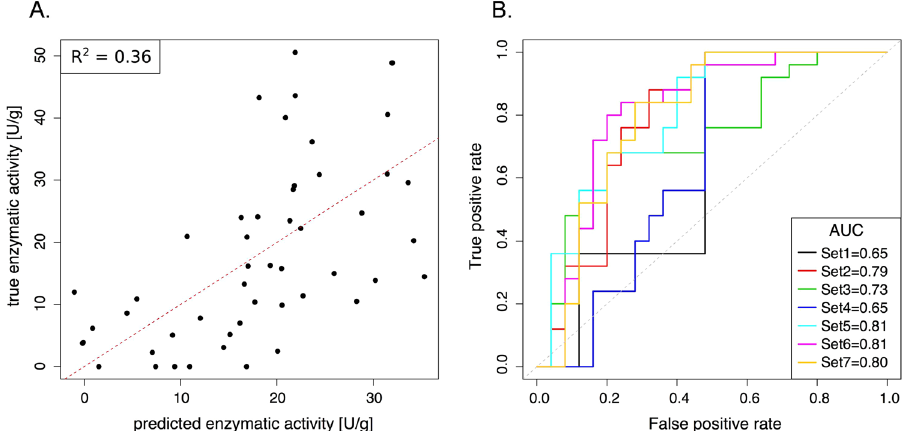
Figure 6. Testing the performance of LCT promoter and enhancer methylation in predicting lactase enzymatic activity levels and the bivariate phenotype lactase persistence/non-persistence. ( A ) Power of combined LCT promoter and enhancer methylation to predict lactase enzymatic activity levels. ( B ) Plot of Area under the curve (AUC) of the receiver-operating characteristic (ROC) calculated using genotype at − 13910C > T (rs4988235), LCT promoter and enhancer DNA methylation, and combinations thereof (shown in detail in Table 3). Perfect prediction corresponds to AUC = 1; random prediction corresponds to AUC = 0.5. Set 1 uses rs4988235 genotype alone, while Set 6 the combination of LCT promoter and enhancer methylation to distinguish lactase persistors from non-persistors. In plots A. and B. one outlier with lactase enzymatic activity at 73.7 U/g was excluded from the analysis. Enzymatic activity data is from Baffour-Awuah et al . 8